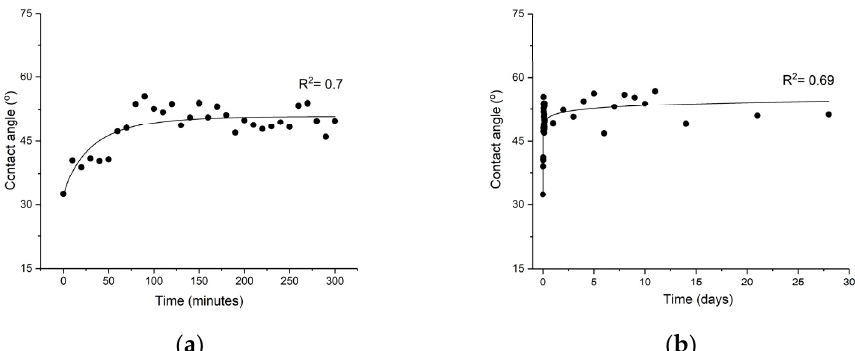
Figure 6. Change of contact angles with ageing following μ Plasma modification for: ( a ) 5 h, ( b ) 4 weeks.